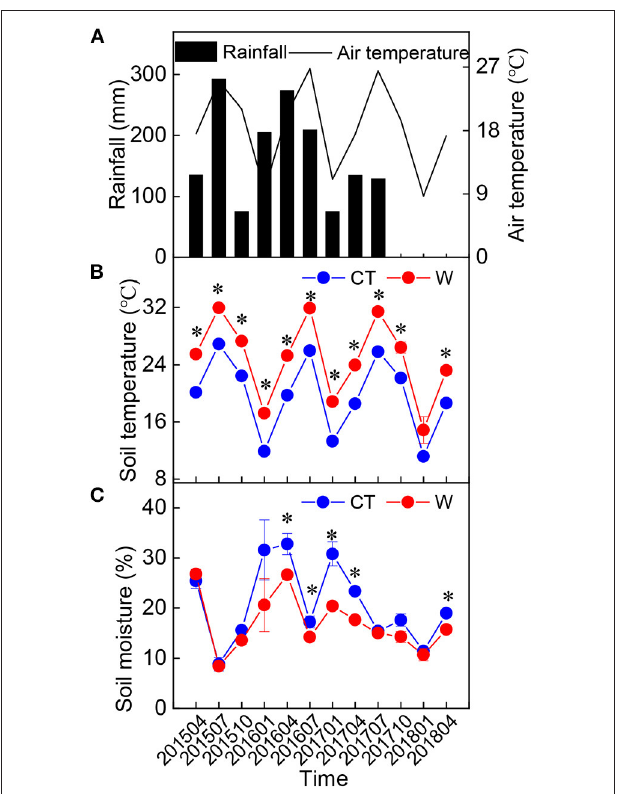
FIGURE 1 | Changes in seasonal rainfall (A) ( n = 1), air temperature (A) ( n = 1), soil temperature (B) (10cm, mean ± standard error, n = 5), and soil moisture (C) (10cm, mean ± standard error, n = 5) in the study area from 2015 to 2018. *Above the dot indicates a significant difference between warming and control treatments at the level of p <